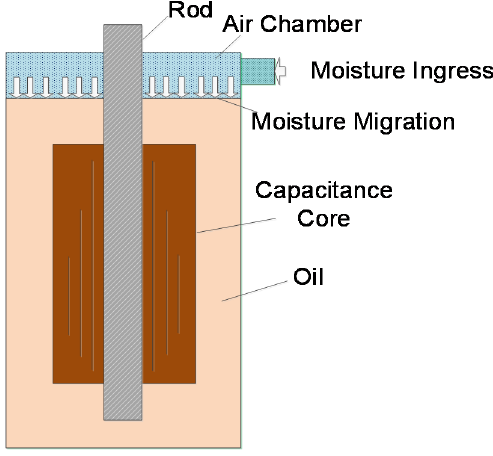
Figure 3. Mass moisture ingress (MI) into bushing.